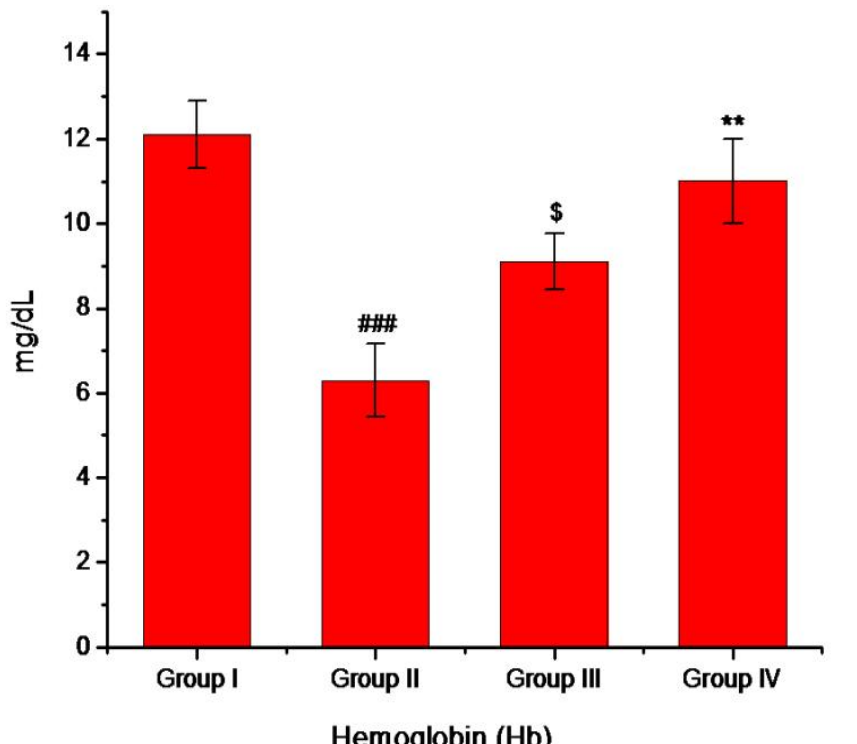
Figure 8. Level of hemoglobin (mg/dl) for the various study groups. Group-I; normal control, Group-II; diabetic left untreated, Group-III; diabetic treated with glibenclamide, Group-IV; diabetic treated with mino/AgNPs. ‘#’ indicates a significant difference between the control and diabetic groups; ‘$’ indicates a significant difference between the diabetic and glibenclamide treatment groups; ‘*’ indicates a significant difference between the diabetic and mino/AgNPs treatment groups. Each bar represents the value of mean ± SD of eight replicates. Statistical icons: $ = p ≤ 0.05; ** = p ≤ 0.01; ### = p ≤ 0.001.